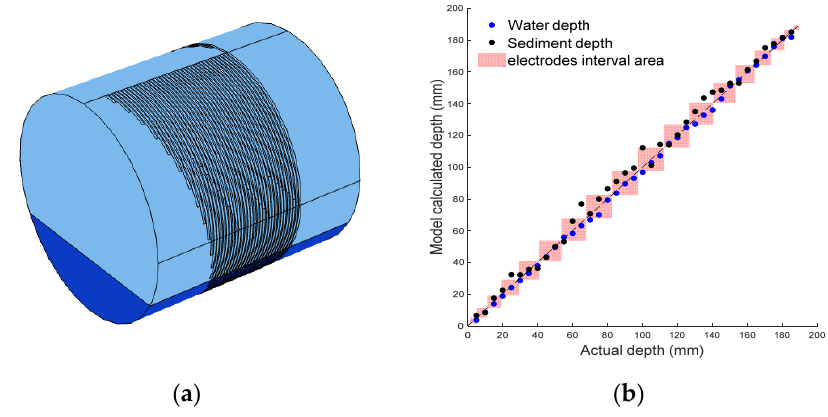
Figure 11. Electrodes fully surround 3D model ( a ). Model results with acceptance range ( b